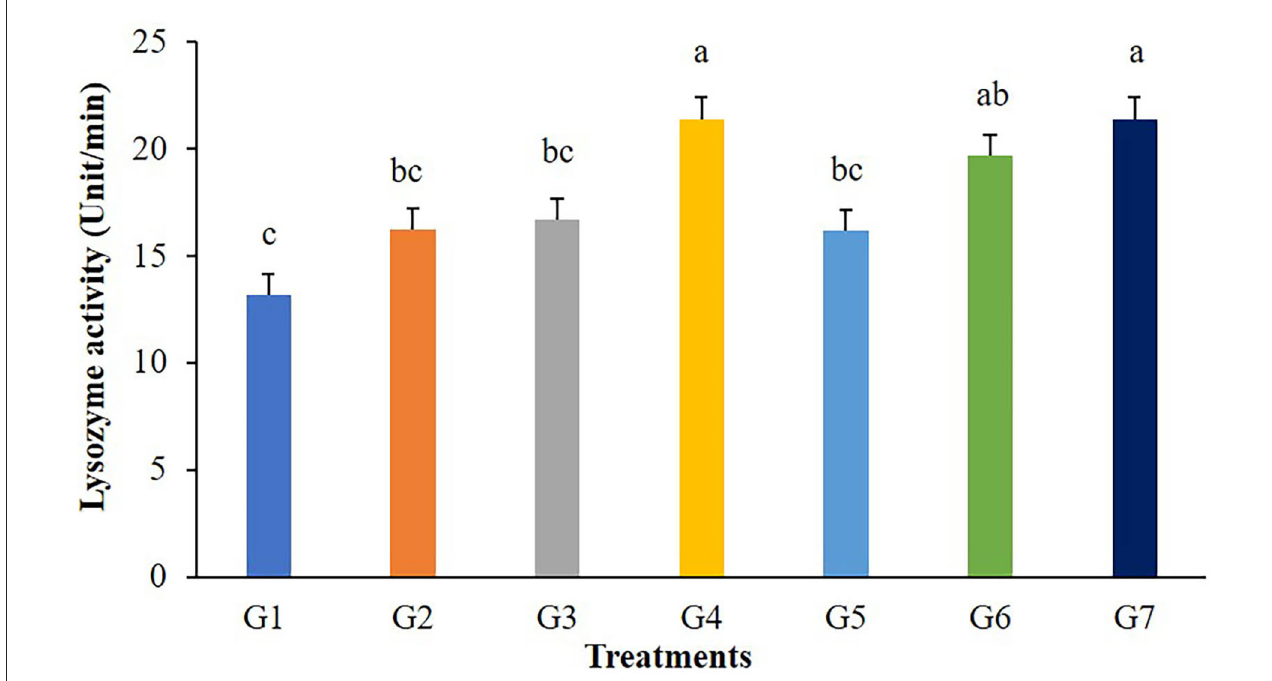
FIGURE3 Lysozyme activity of Nile tilapia fed with FOS and B. subtilis for 56 days ( n = 5). Bars with different letters indicate significant difference ( P <